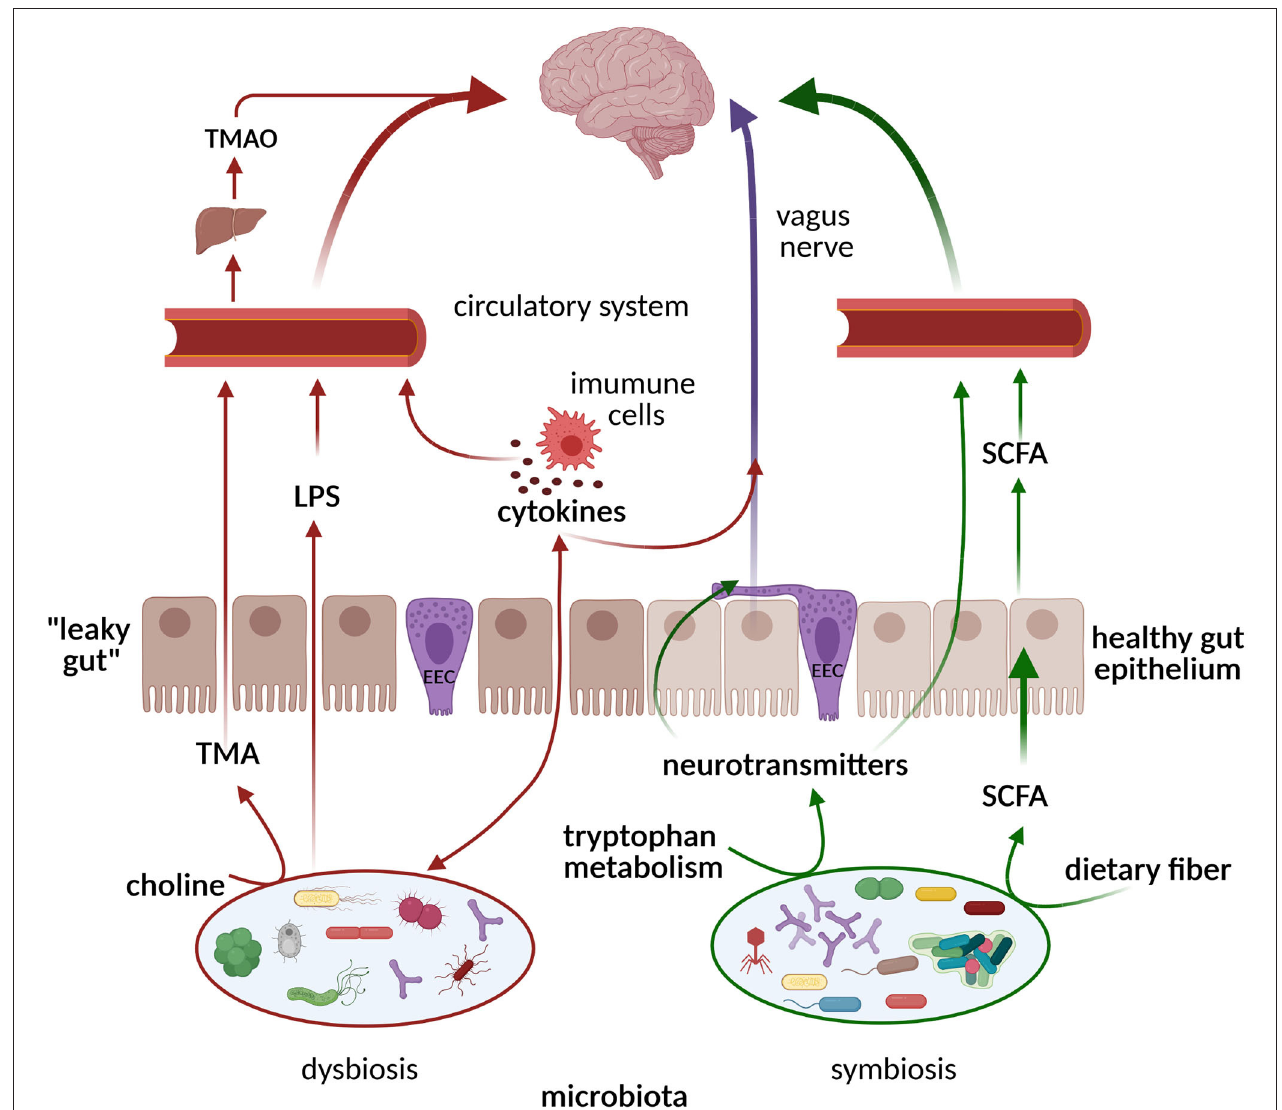
FIGURE 2 | Pathways of communication along the gut microbiome–brain axis. In the state of symbiosis, the gut microbiota produces SCFAs, tryptophan metabolites, and neurotransmitters that exert neuroprotective effects on the brain via circulation and the vagus nerve (green arrows). In the state of dysbiosis, TMA/TMAO, pro-inflammatory cytokines, and LPSs are formed, inducing cognitive impairment (red arrows). ECCs, enteroendocrine cells; SCFAs, short-chain fatty acids; LPSs, lipopolysaccharides; TMA, trimethylamine; TMAO, trimethylamine N-oxide. Created with